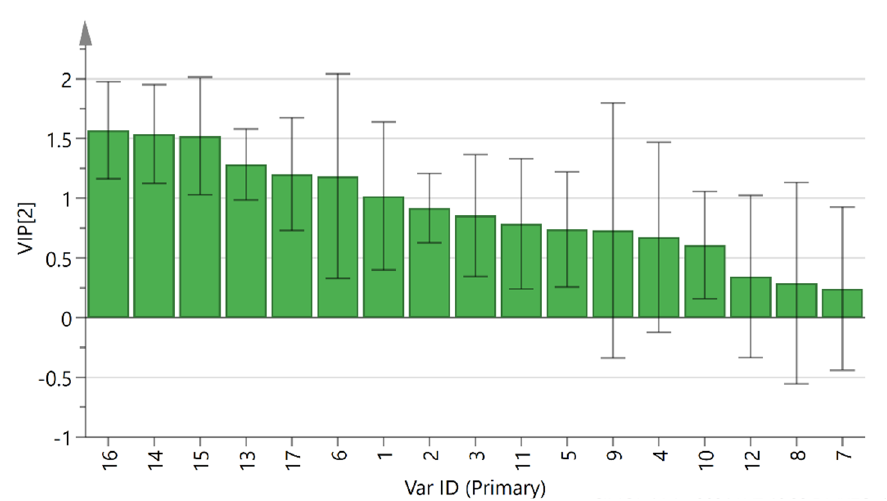
Figure 5. PLS-DA diagram of 27 batches of AMR sample.